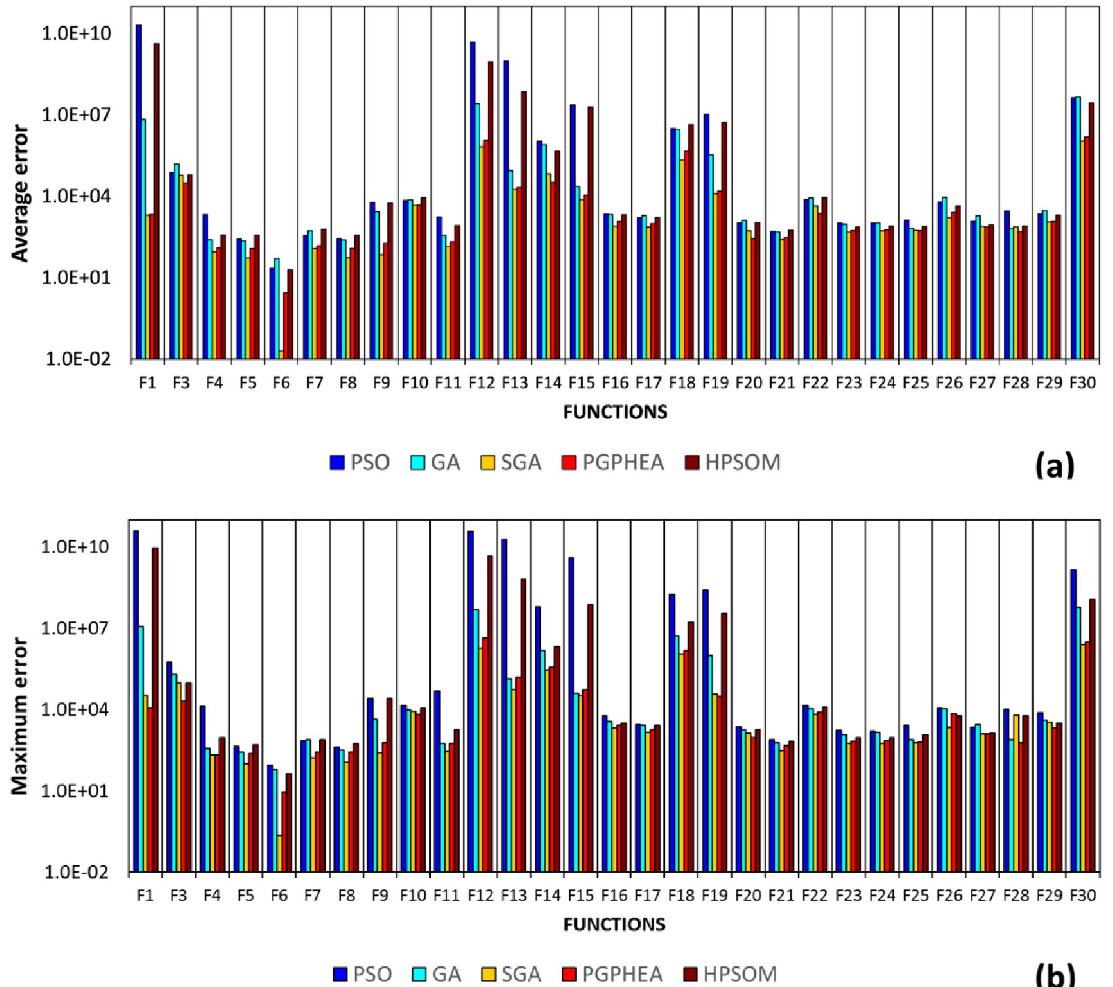
Fig 10. Comparison of algorithmic performance in solving continuous problems of Set B (CEC 2017): a) average error, b) maximum error in predicting the global optimum.